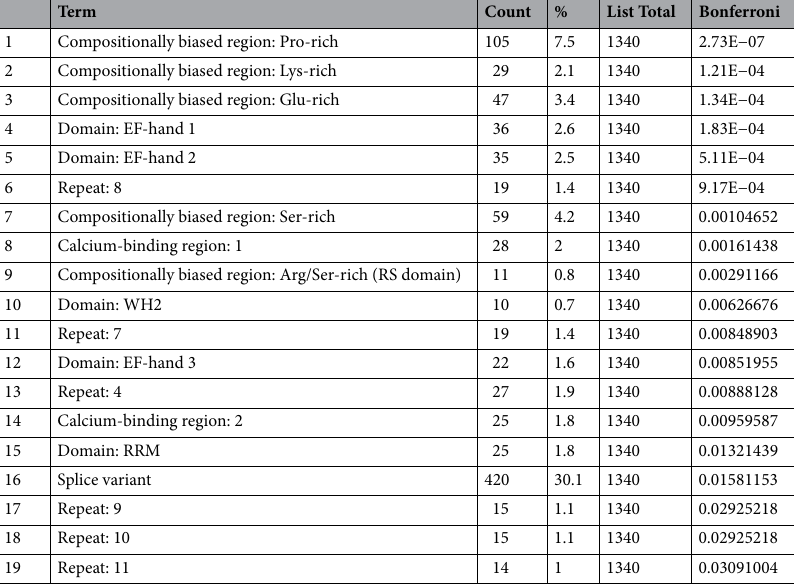
Table 2. The sequence features of S2h proteins analyzed by